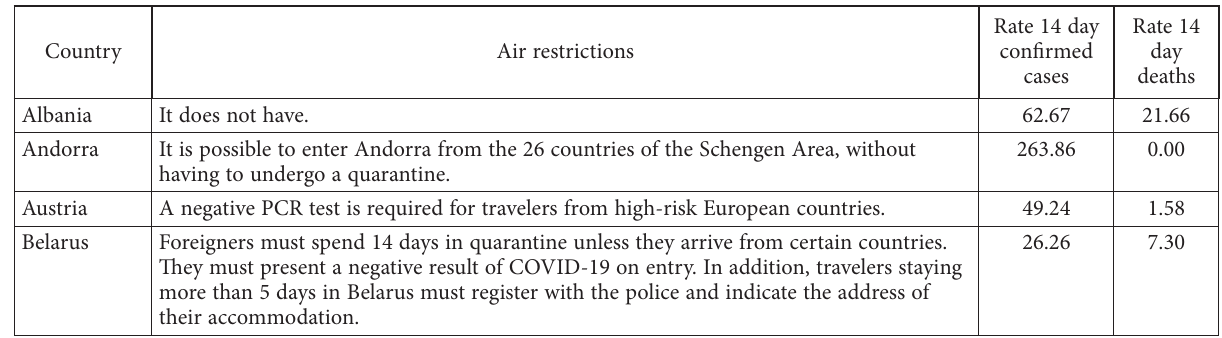
Table 1. Passenger traffic restrictions in Europe considering the 14-day reporting rate of COVID-19 cases (source: own elaboration based on public information available on the websites of the Ministries of Health of each country and the European Centre for Disease Prevention and Control,